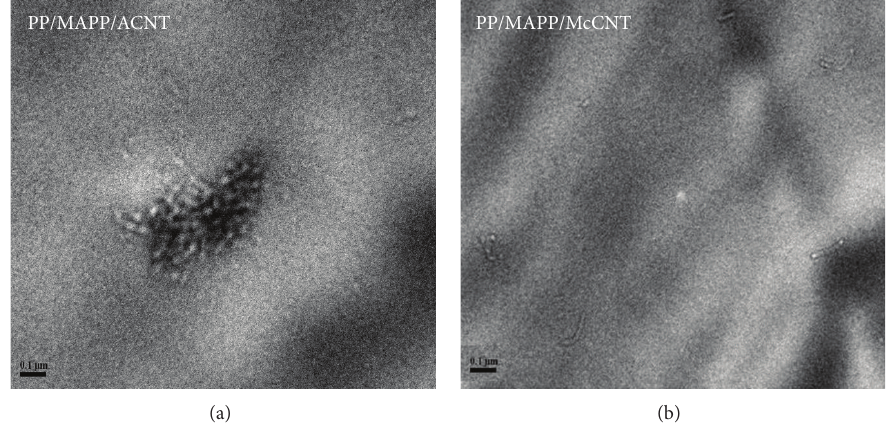
Figure 8: TEM images of PP